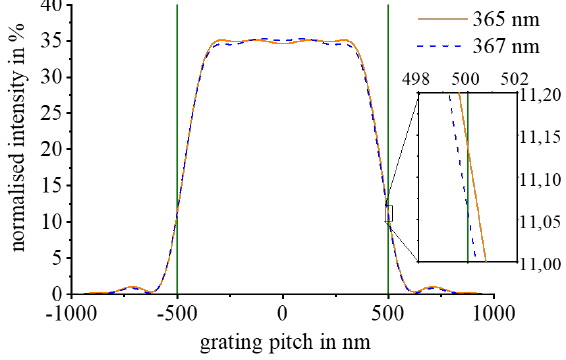
Fig. 3. Simulated profiles for two wavelengths; NA ill. = NA img. = 0,9; magnification =